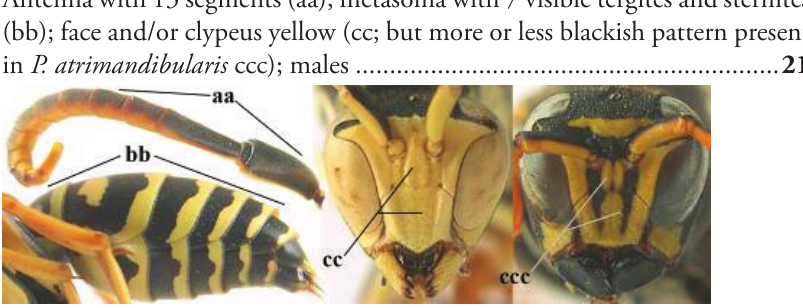
Mandible very stout and its outer face more or less depressed (a); ventral border of clypeus strongly convex (b) and medially acute (c); socio-parasitic species ......................................................................................................... 6